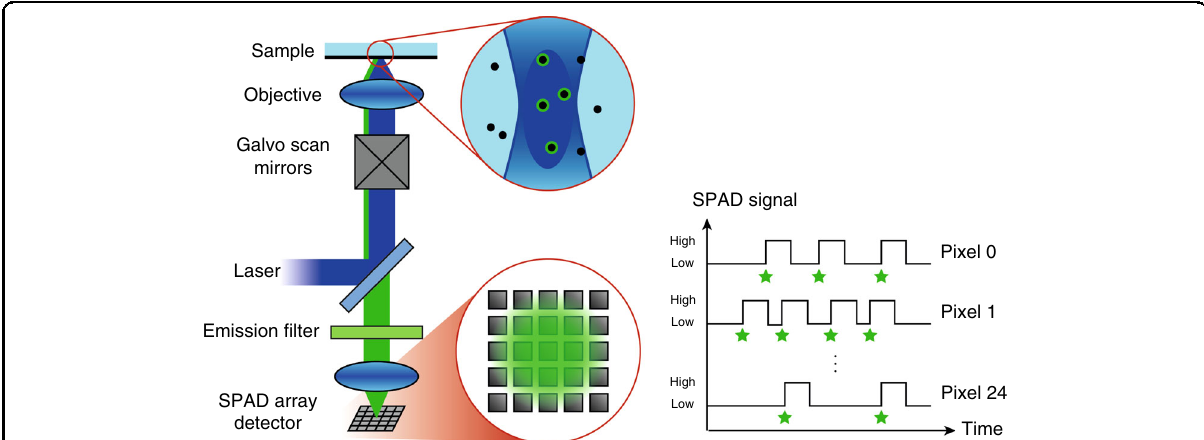
Fig. 1 Imaging the fl uorescence signal in a confocal setup with a SPAD array detector. The 25 pixels of the detector are numbered from 0 for the pixel in the top left corner to 24 for the pixel in the bottom right corner. Each photon, represented by a green star, instantaneously creates a local high-voltage signal in one of the SPAD pixels, which can be read out asynchronously and independently from the other